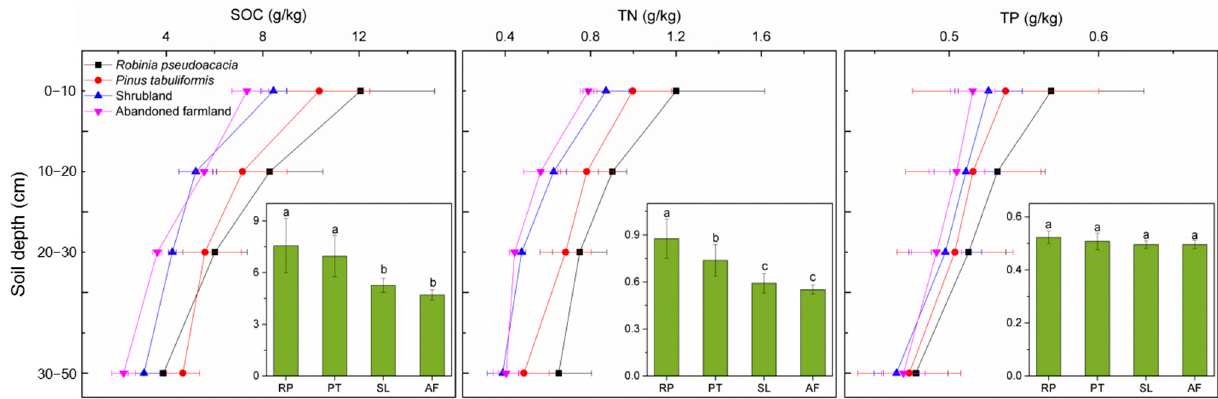
Figure 2. The SOC, TN and TP varied with soil depth in different vegetation types. The error bars indicate the standard error. The bar chart shows mean ± SE (0–50 cm). Different letters represent significant differences between different vegetation types ( p < 0.05). RP, R. pseudoacacia forest; PT, P. tabuliformis forest; SL, shrubland; AF, abandoned farmland.